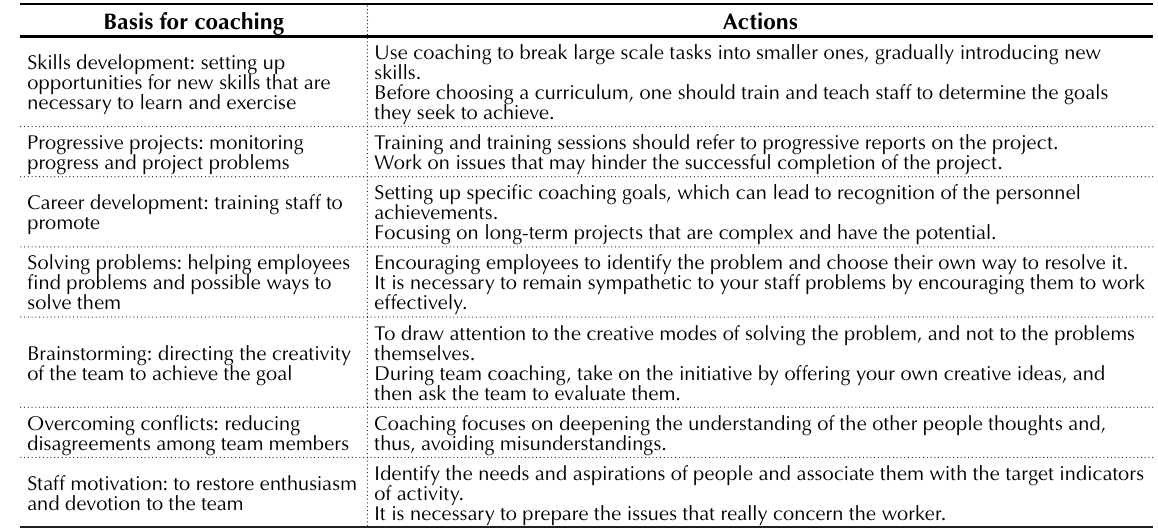
Source : Adapted from Eaton and Johnson